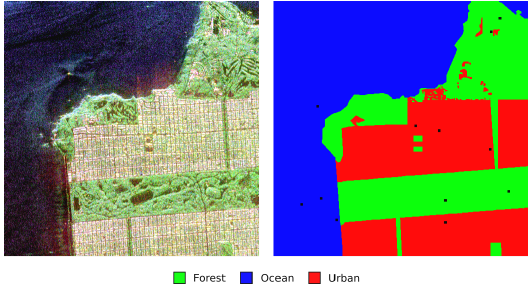
Figure 4. San Francisco Bay image (left) and ground truth labels (right). Training samples are marked as black squares (best viewed with magnification).